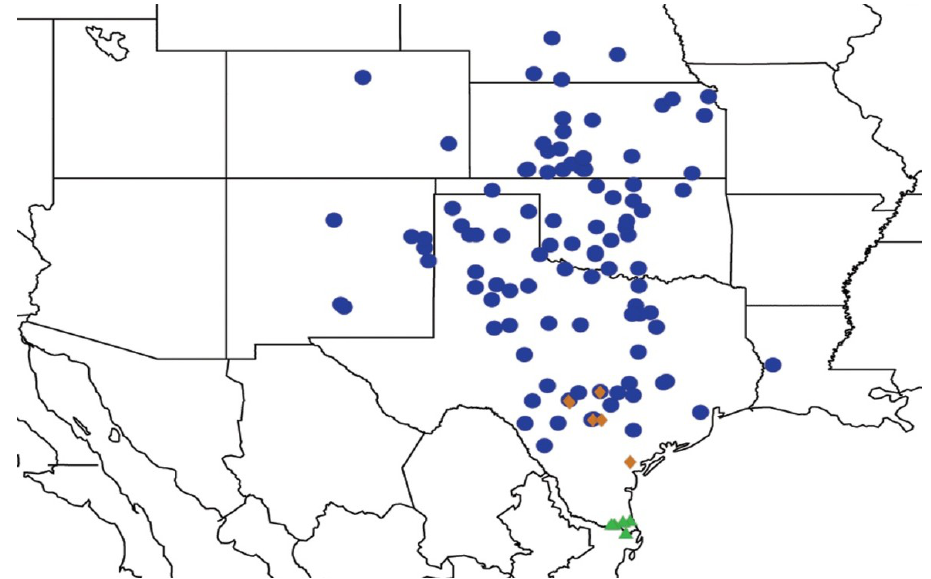
Figure 34. Distribution of Cicadetta kansa (blue circles), C. texana (orange diamonds) and C. camerona (green